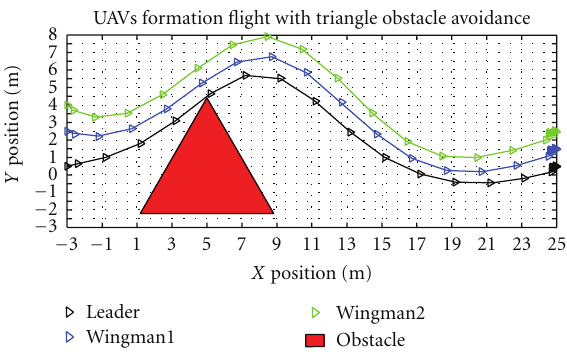
Figure 7: Triangle obstacle collision avoidance.